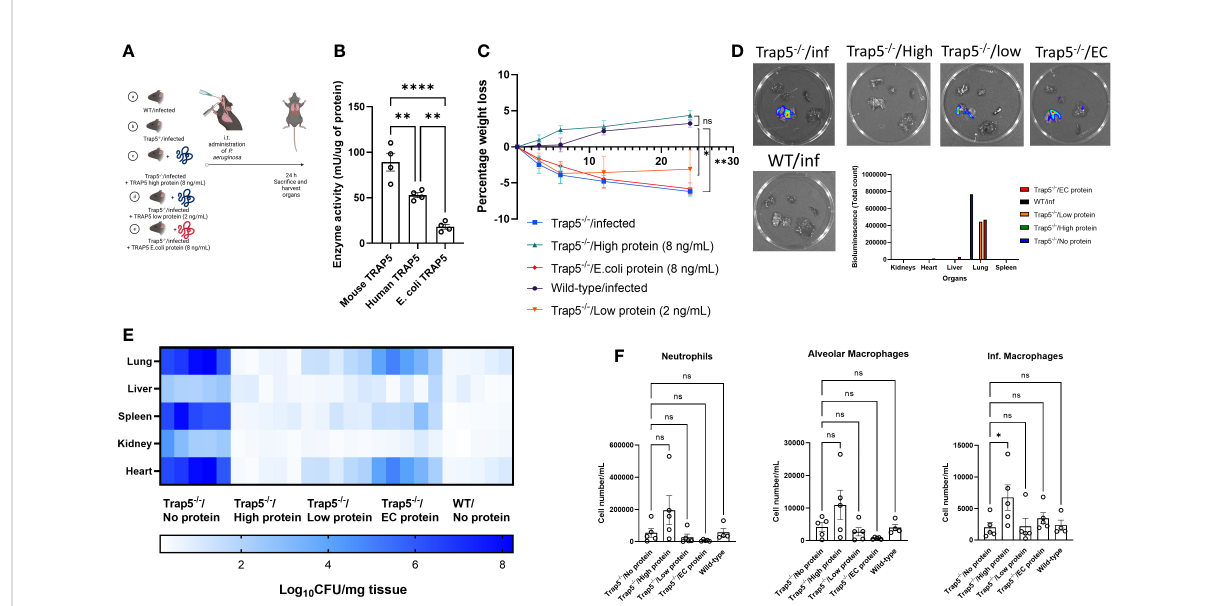
FIGURE 6 Functional TRAP5 protein rescues TRAP5 knockout animals from Pseudomonas aeruginosa lung infection. (A) Experimental layout showing time points at which bacteria were administered to mice, with proteins administered 30 min before infection (n=5 per group). (B) Commercially available TRAP5 proteins were tested for their enzymatic activity using a phosphatase activity assay. Statistical analysis was conducted using one-way ANOVA with a Dunnet ’ s post hoc test (** P < 0.01; **** P < 0.0001). (C) Following i.t. administration of different proteins and bacteria, mice were monitored for weight loss over 24 h. Statistical analysis was performed using student ’ s t -test (* P < 0.05; ** P < 0.01). (D) Mice